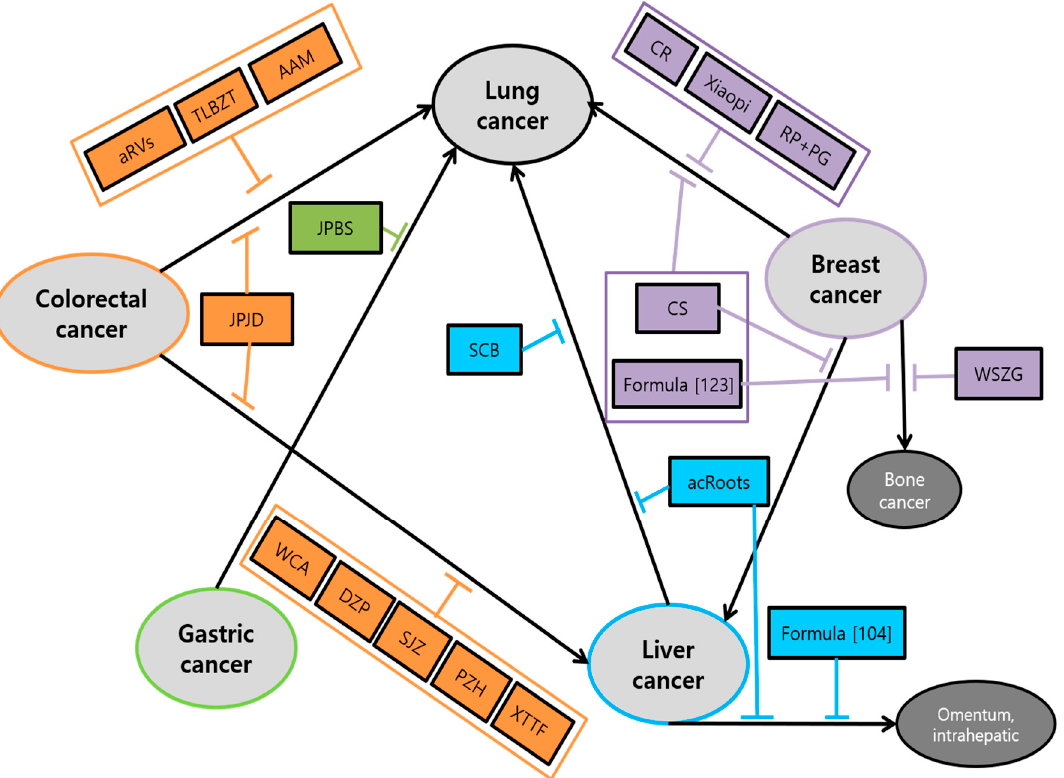
Figure 6. Schematic diagram of herbal medicine used for mutual organs metastasis: In addition to inhibitory actions against individual types of cancers, herbal medicine can be effectively applied to some metastatic interactions between five major cancers. Herbal medicine prevents the metastasis of the five major cancers to each other. In particular, there were a number of herbal medicines that prevent cancer from spreading to the lung. Abbrevation: aRVS, allergen-removed Rhus verniciflua stokes extract combined with Dokhwaljihwang-tang; TLBZT, Teng-Long-Bu-Zhong-Tang; AAM, Astragalus Atractylodes mixture; JPJD, Janpi Jiedu; WCA, Weichang’an; DZP, Dahuang Zhechong Pill; SJZ, Modified Si-Jun-Zi Decoction; PZH, Pien Tze Huang; XTTF, Xiaotan Tongfu; JPBS, Jianpi Bushen; SCB, Salvia chinensis Benth; acRoots, Actinidia chinensis Planch root; CR, Curcumae Radix ; RP+PG, Ruyiping with Platycodon grandiflorum ; CS, Camellia sinensis ; WSZG, Wensheng Zhuanggu.